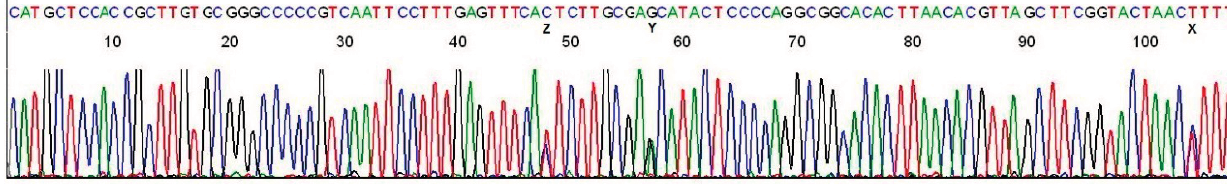
Figure 8. A 107-base segment of the base-calling DNA sequencing electropherogram showing two superimposed DNA sequences, one of B. burgdorferi and one of B. miyamotoi . There are three characteristic double base peaks at positions 770, 815 and 826 (Table 1) in this signature sequence, representing concomitant borrelial infections by these two species in one patient blood sample. The M2 primer was used as the sequencing